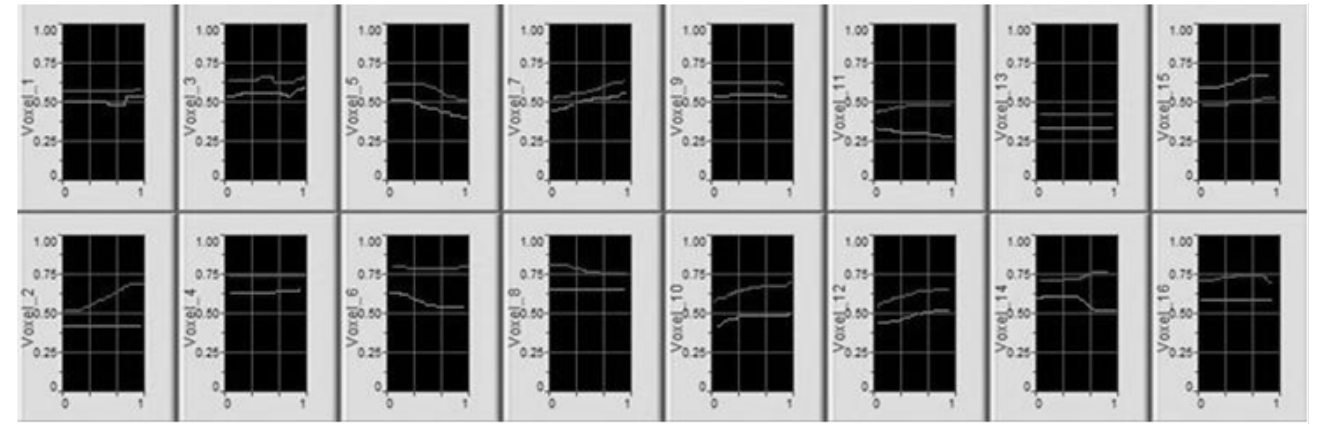
Figure 3 - fNIRS interface. Lines demonstrate the blood flow variation for each